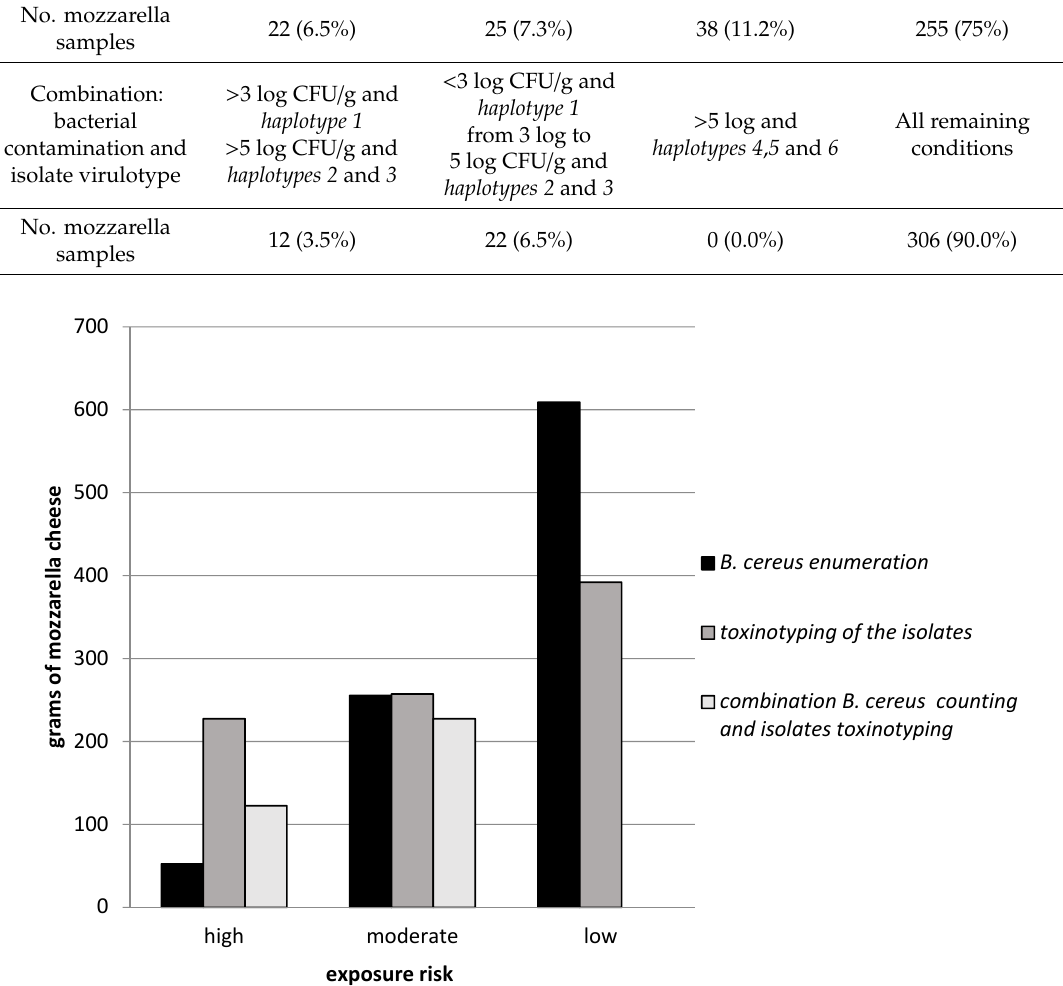
Figure 1. Annual amount of mozzarella consumed, subdivided by level of risk (high; moderate; low) and the method of risk determination ( B. cereus counting; molecular profiling of isolates; combined evaluation: B. cereus counting plus molecular profiling of isolates).